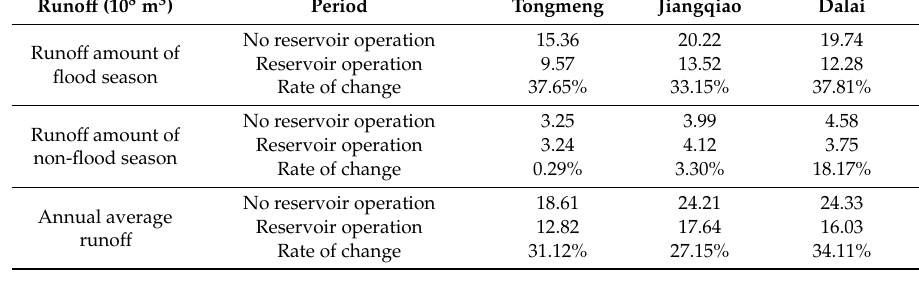
Table 2. Statistical runo ff results of stations before and after the reservoir was constructed.